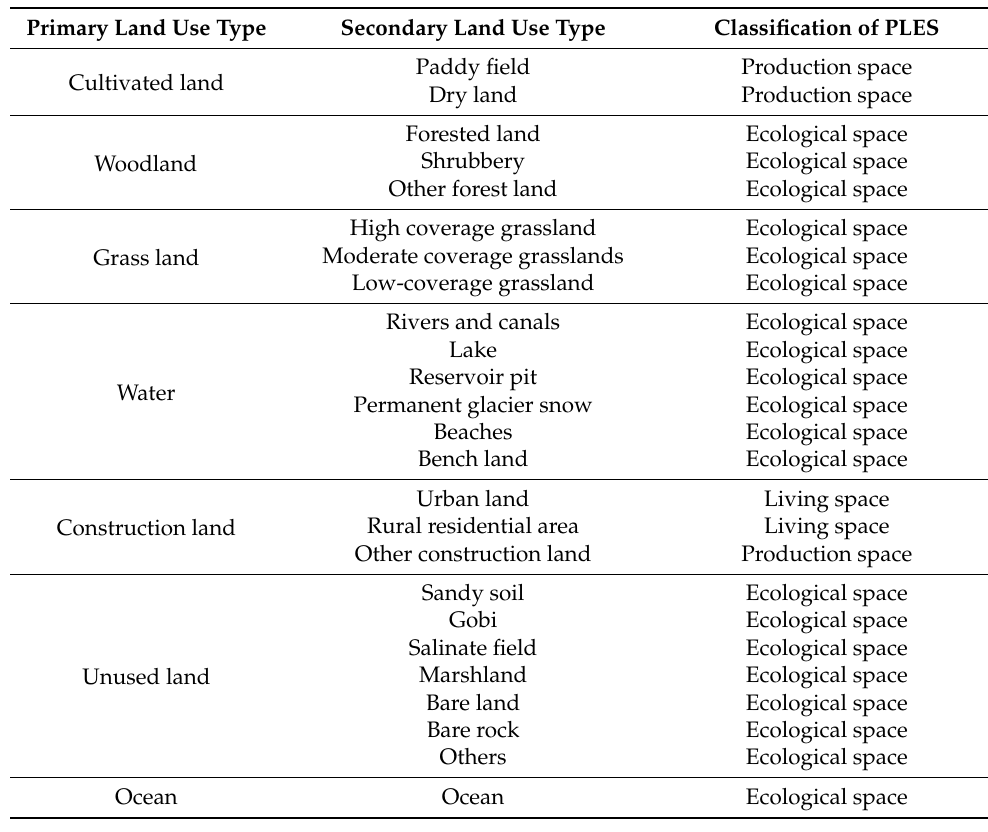
Table 1. Classification of